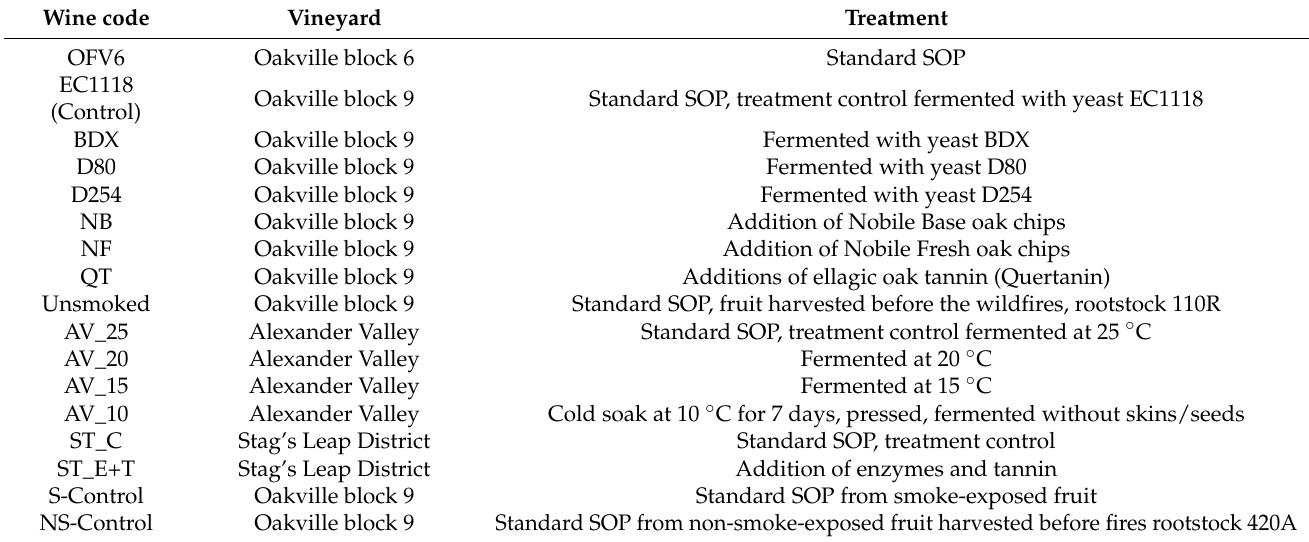
Table 6. Treatment description and wine